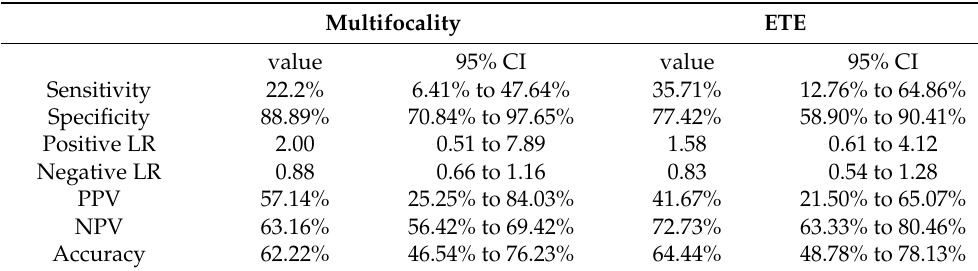
Table 4. Diagnostic performance of US findings in predicting multifocality and ETE.